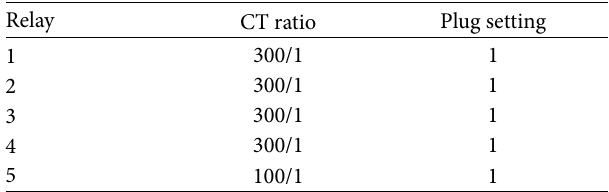
Table 12: CT ratios and plug setting of the relays.